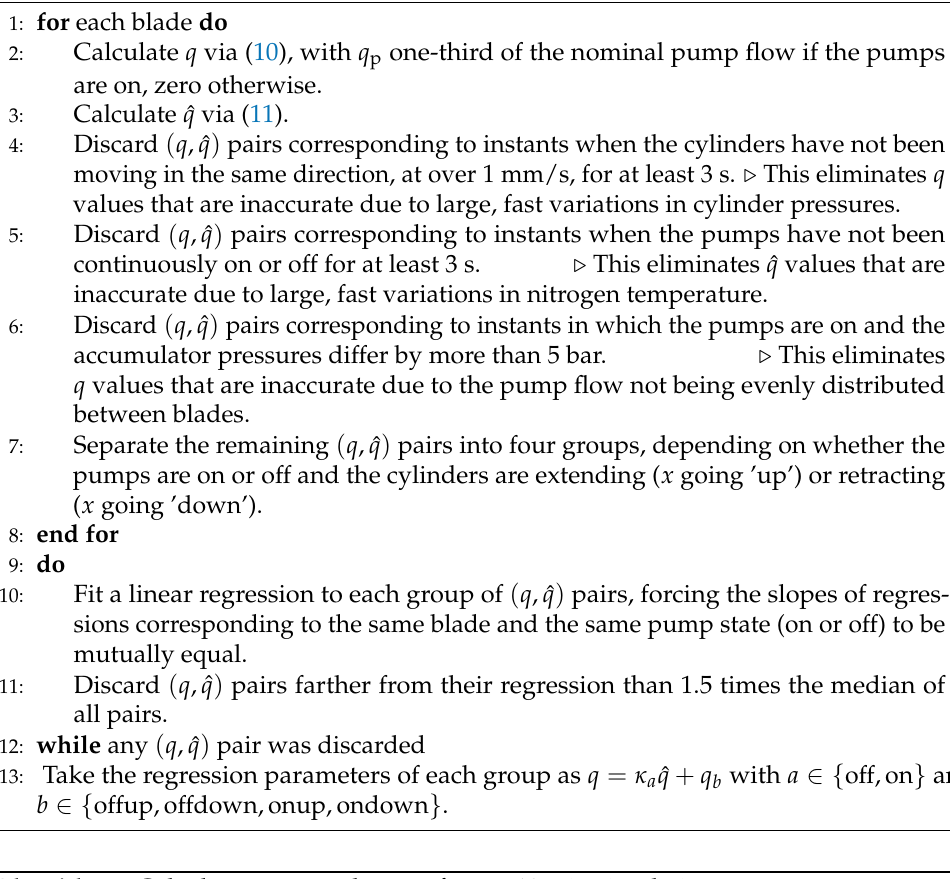
Algorithm 1 Calculate κ off , κ on , q offup , q offdown , q onup and q ondown from a 10 min simulation.